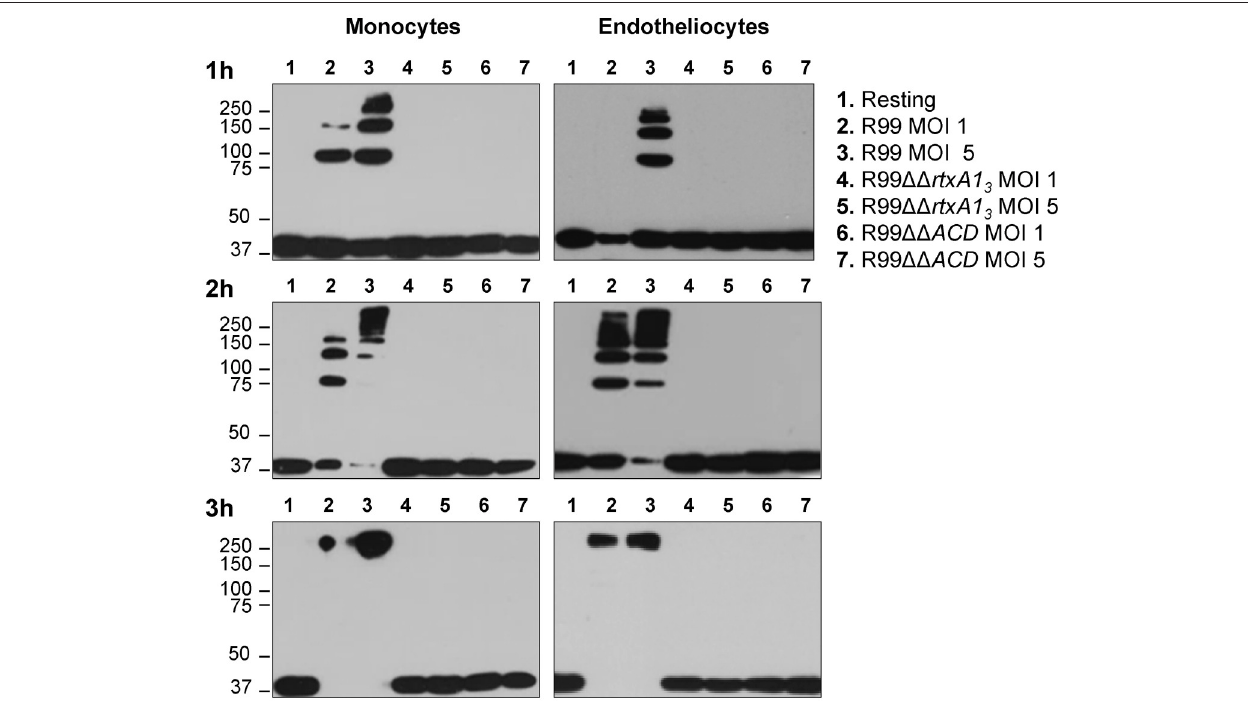
FIGURE 3 | Role of the ACD domain in actin polymerization. V. vulnificus R99, R99 11 rtxA1 3 , and R99 11 ACD cells were added at MOIs of 1 and 5 to THP-1 suspension cells and ECV304 adherent cells for 1, 2, and 3 h. Cell lysates were separated by SDS-PAGE and western blotted to detect polymerization of α -actin. Data are representative of two independent